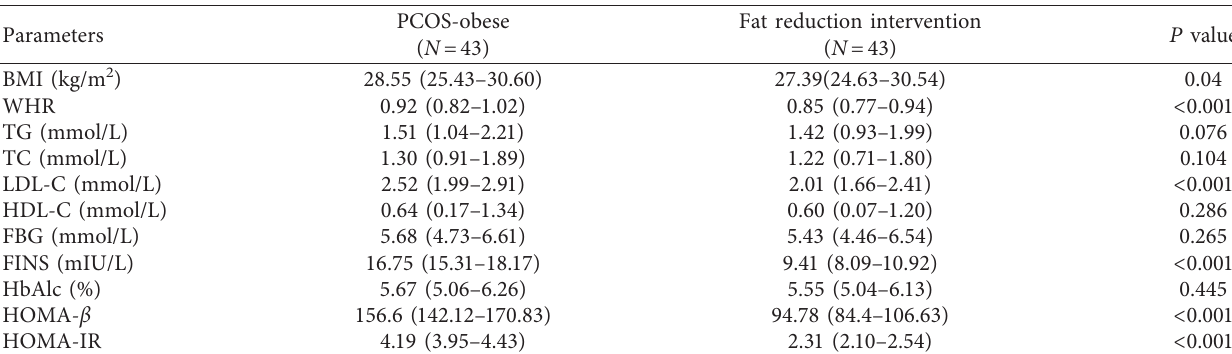
Table 4: Changes of clinical parameters in PCOS-obese patients during the 3-month intervention of fat reduction. Parameters